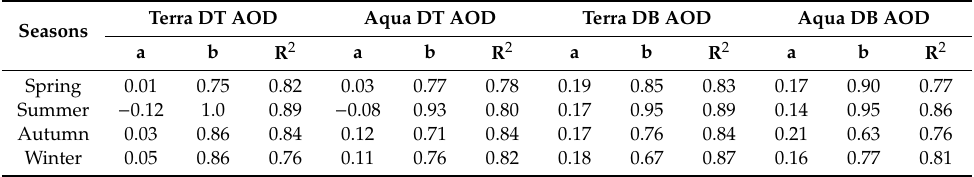
Table A2. Linear regression models for the four MODIS AOD datasets calibration.